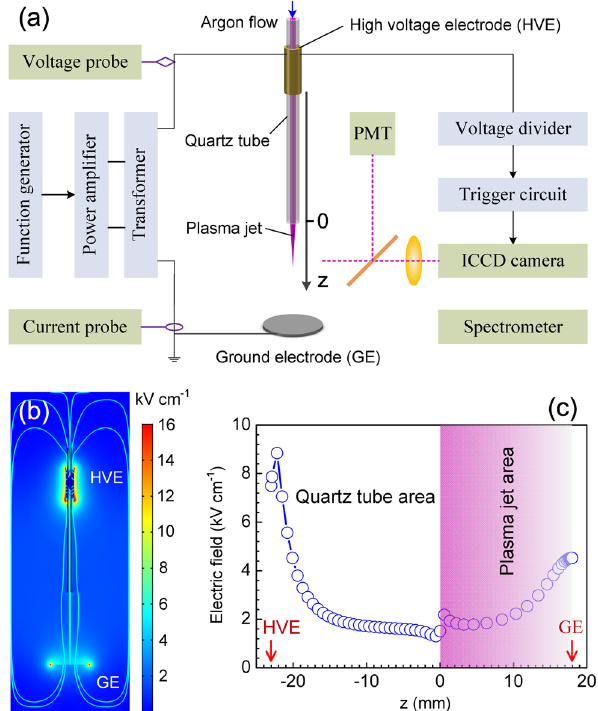
Fig. 1 Experimental arrangement and electrostatic fi eld characterization. a Schematic diagram of the experimental setup. The gas fl ow is indicated by the blue arrow. The plasma jet extends along the z -axis. HVE, GE, PMT, and ICCD mean the high-voltage electrode, ground electrode, photomultiplier tube, and intensi fi ed charge-coupled device, respectively. b The electrostatic fi eld pattern of the cylindrical dielectric-barrier discharge (DBD), modeled by imposing a potential 11 kV between the electrodes. The relative permittivity of quartz tube is set as 3.7. c The distribution of electric fi eld along the central axis of the quartz tube. The blue circles are the simulation data of electric fi eld. The position of HVE and GE is marked by the red arrow. The shaded region is introduced in order to focus the attention on the area, where a plasma jet could be